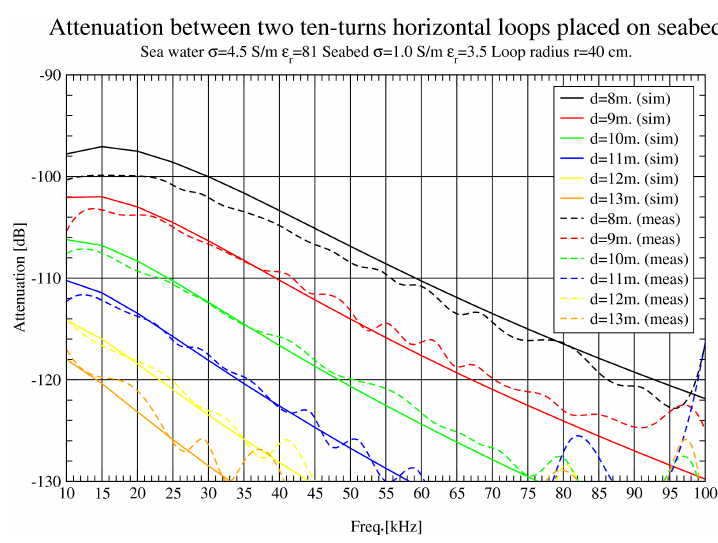
Figure 12. Path loss (dB) comparison up to 13 m (10 KHz–100